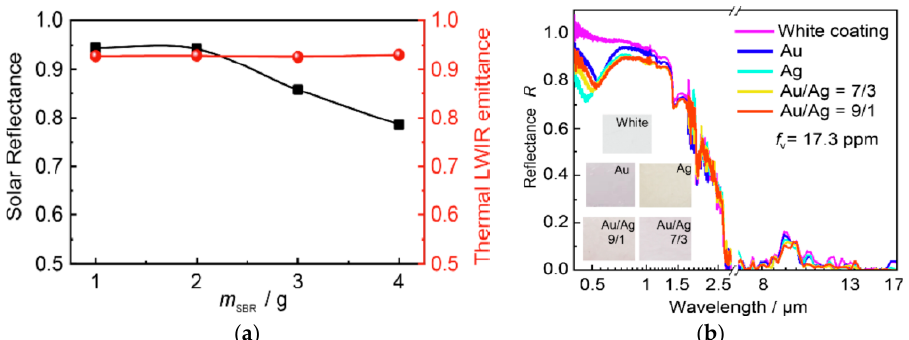
Figure 24. ( a ) Spectral reflectance (R solar = 94.2%) and longwave infrared emissivity ( ε LWIR = 0.93) using SiO 2 sphere DPRC coatings and ( b ) Coloured DPRC coatings based on Au-Ag spheres (note: white and colored coatings are 300 μ m and 310 μ m thick, respectively) [133].